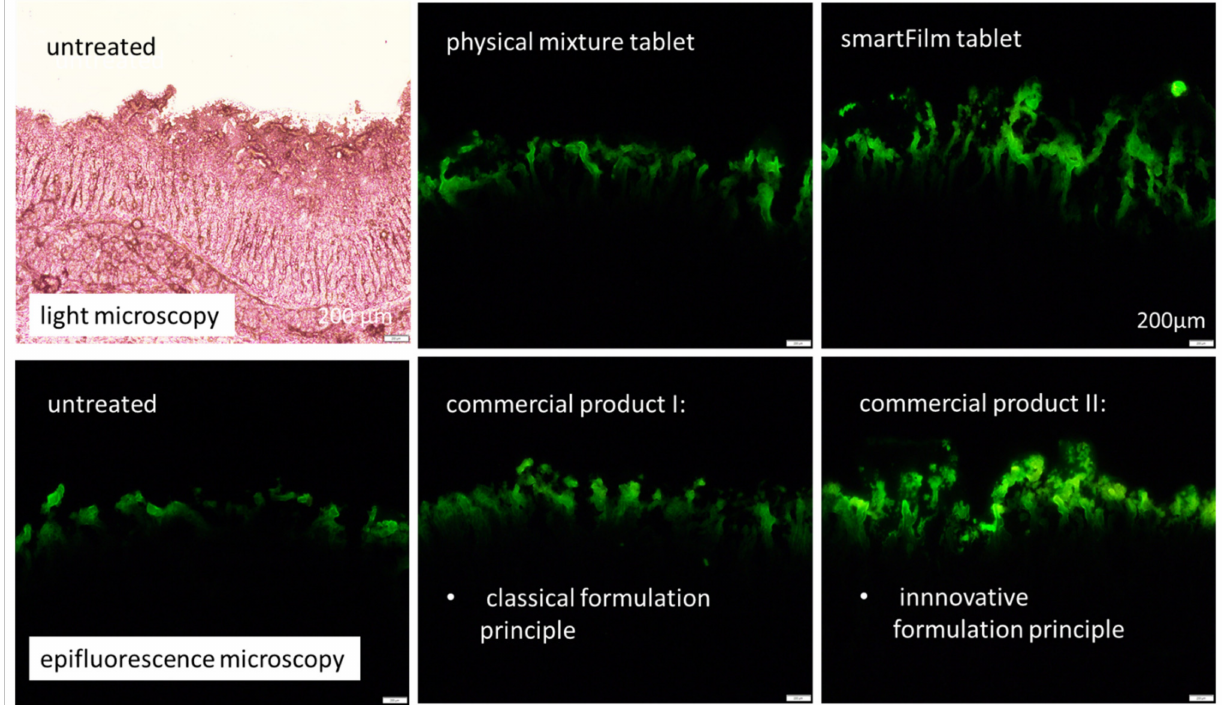
Figure 6. Epifluorescence microscopic images (40-fold magnification) of porcine intestinal sections treated with different curcumin-loaded formulations, as compared to the untreated intestinal tissue. In addition, an image of the intestinal tissue with similar magnification taken with light microscopy is shown to visualize the morphology of the intestinal tissue used for the study ( upper left ). Scale bars correspond to 200 µ